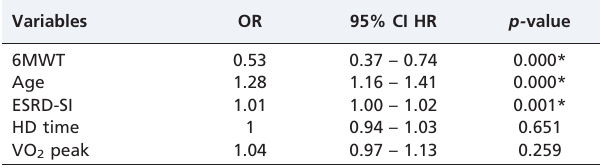
Table 2 - Cox univariate analysis stratified per 100 meters.